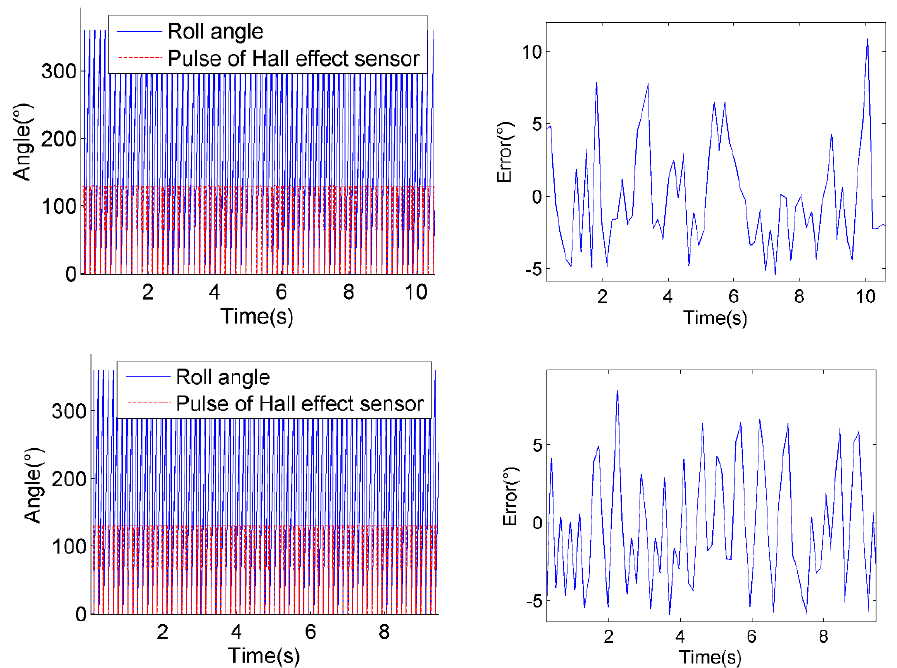
Figure 23. The deviations of estimated roll angles comparing to Hall Effect sensor measurements of 3.8 r/s (top), 6.4 r/s (middle) and 7.5 r/s (bottom).